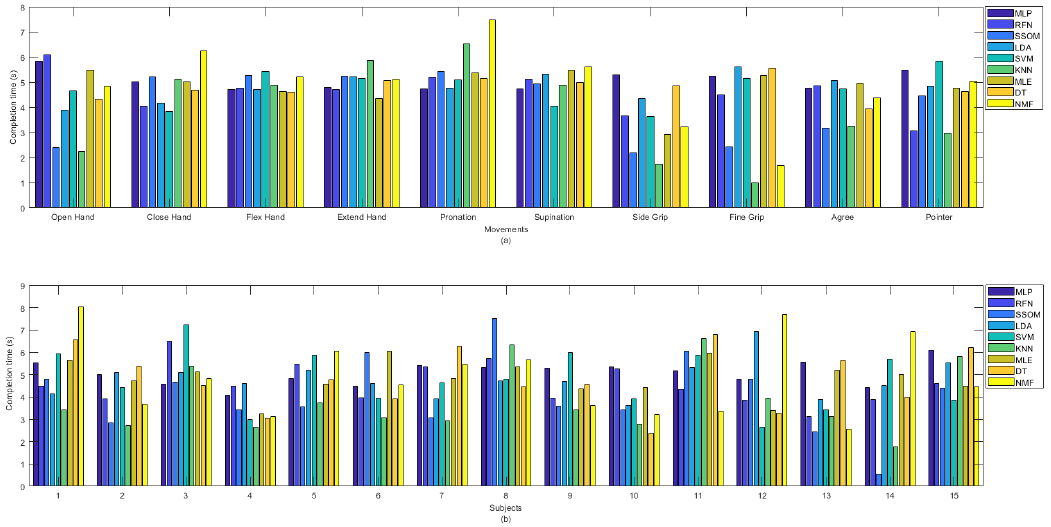
Figure 7. Completion time in second between classifiers per ( a ) movements and ( b ) subjects.